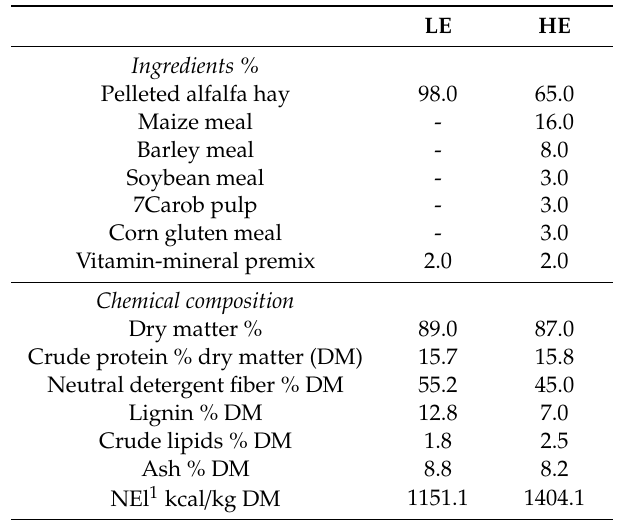
Table 1. Ingredients and chemical composition of the experimental